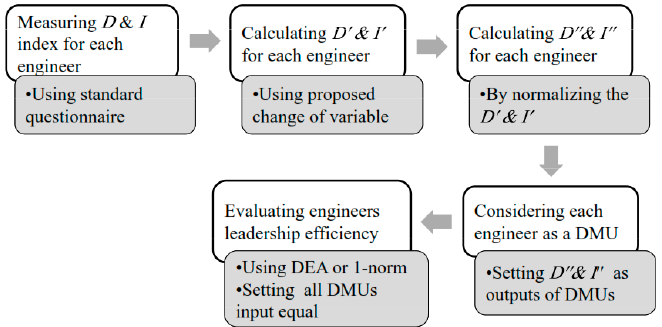
Figure 2. Proposed method and tools or techniques used in each step.